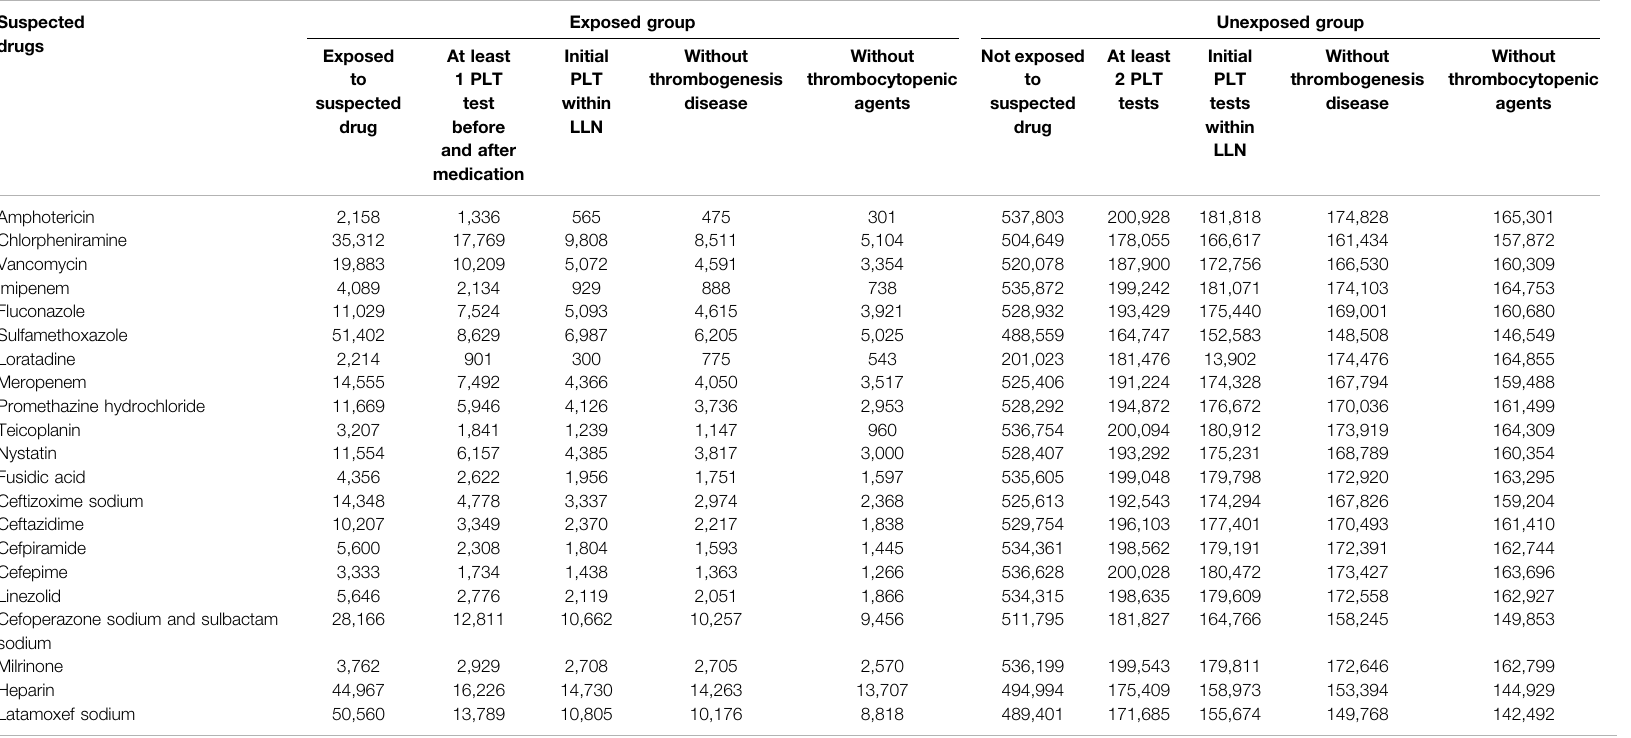
TABLE 2 | The data fi ltering work fl ow for suspected